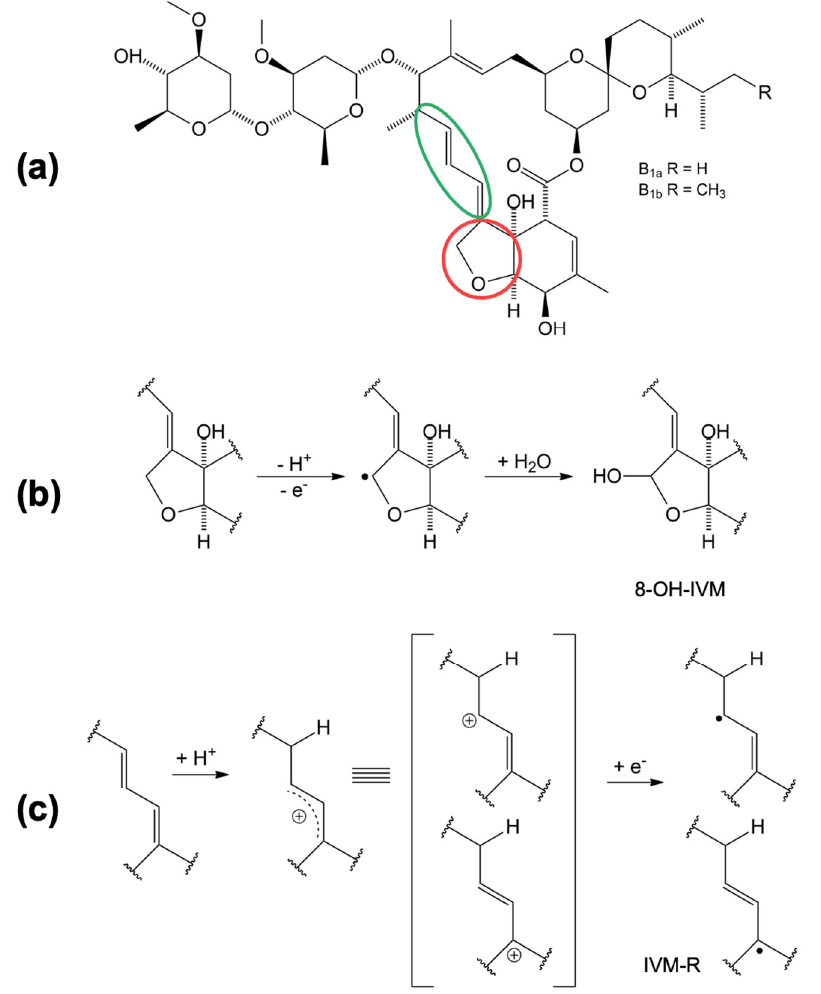
Figure 5. Proposed oxidation and reduction reaction mechanisms of IVM; ( a ) IVM structure with oxidation site marked in red and reduction site marked in green; ( b ) oxidation mechanism; ( c ) reduction mechanism.